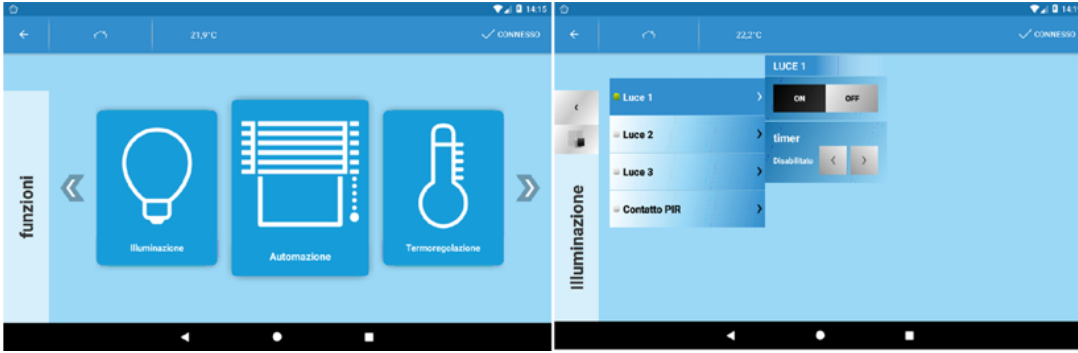
Figure 6. Snapshots of the Home Automation App for monitoring and control the